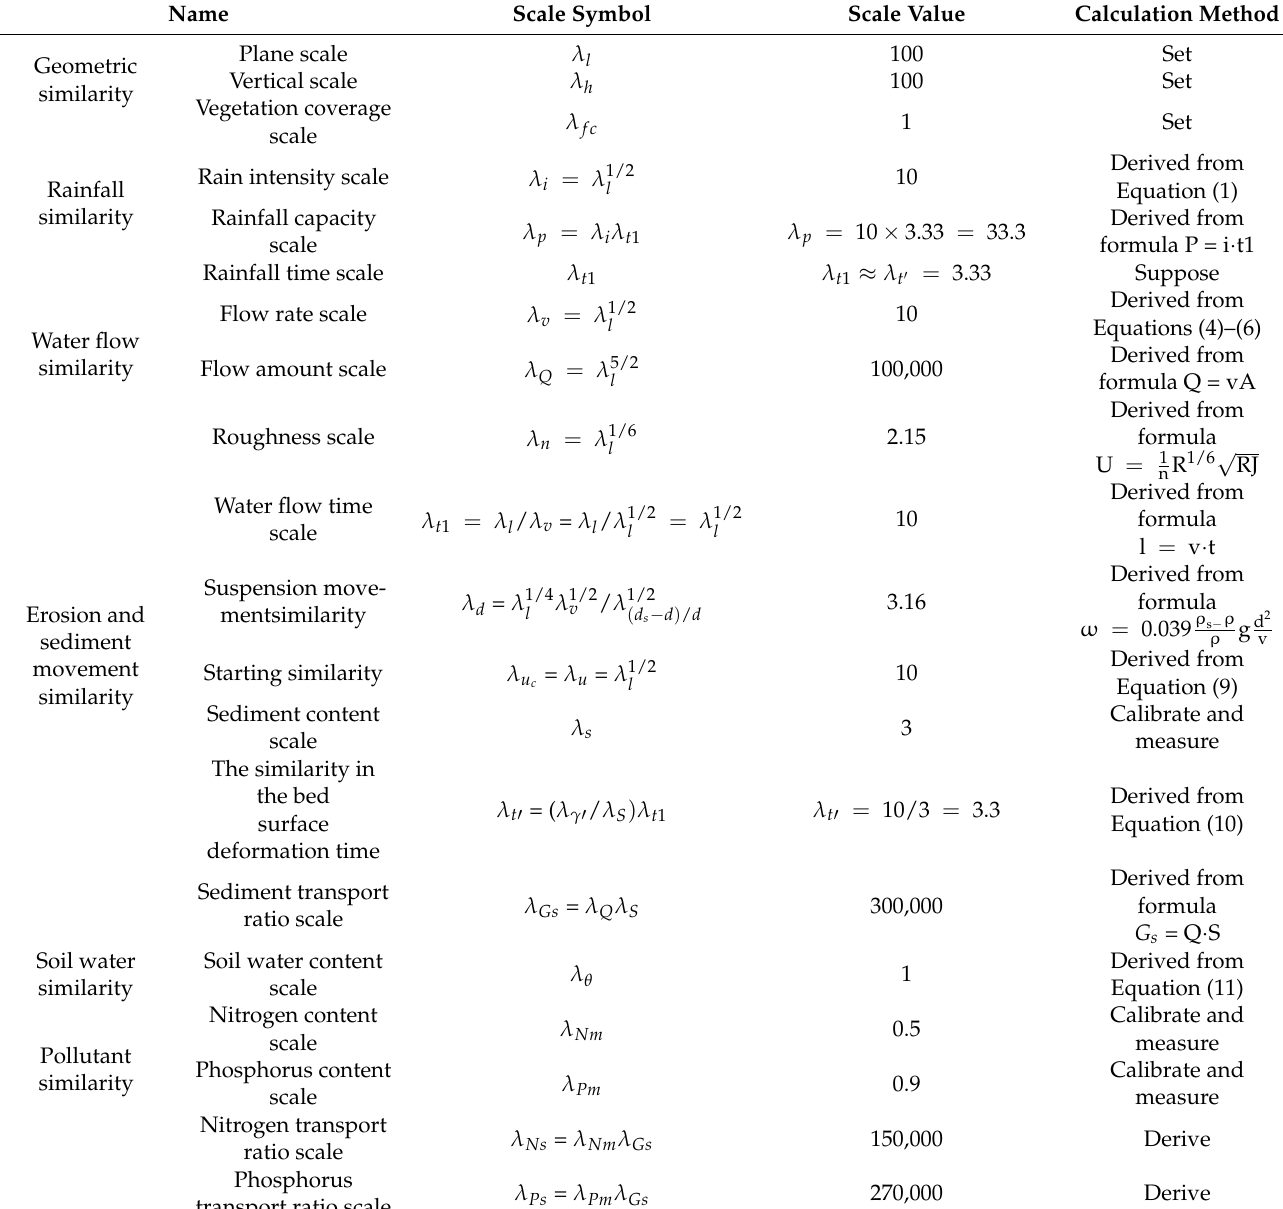
Table 2. Summary of the main scales of the small watershed